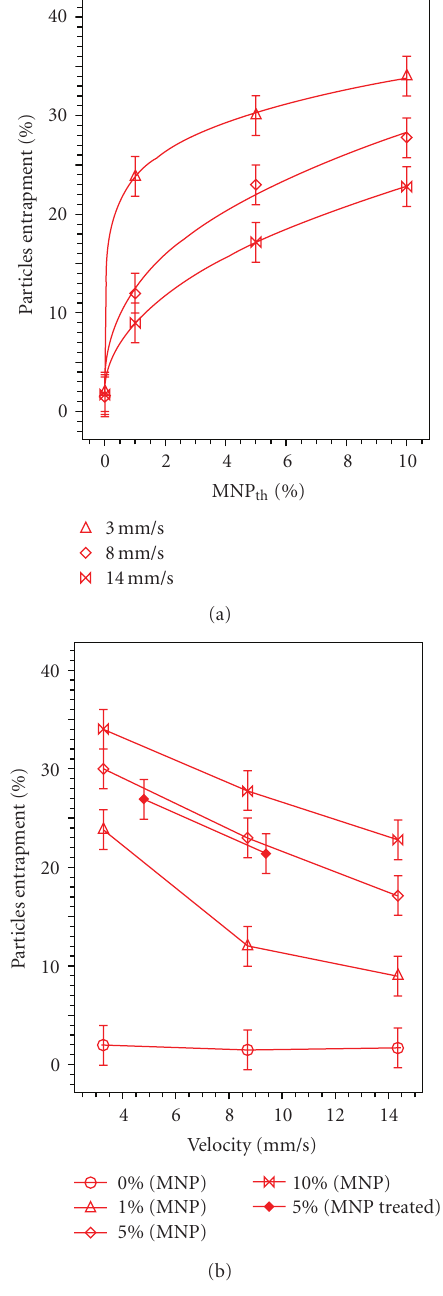
Figure 6: Entrapment of triestearin-magnetite particles as a function of : (a) percentage of magnetite in the starting lipid mixture and (b) fluid velocity.